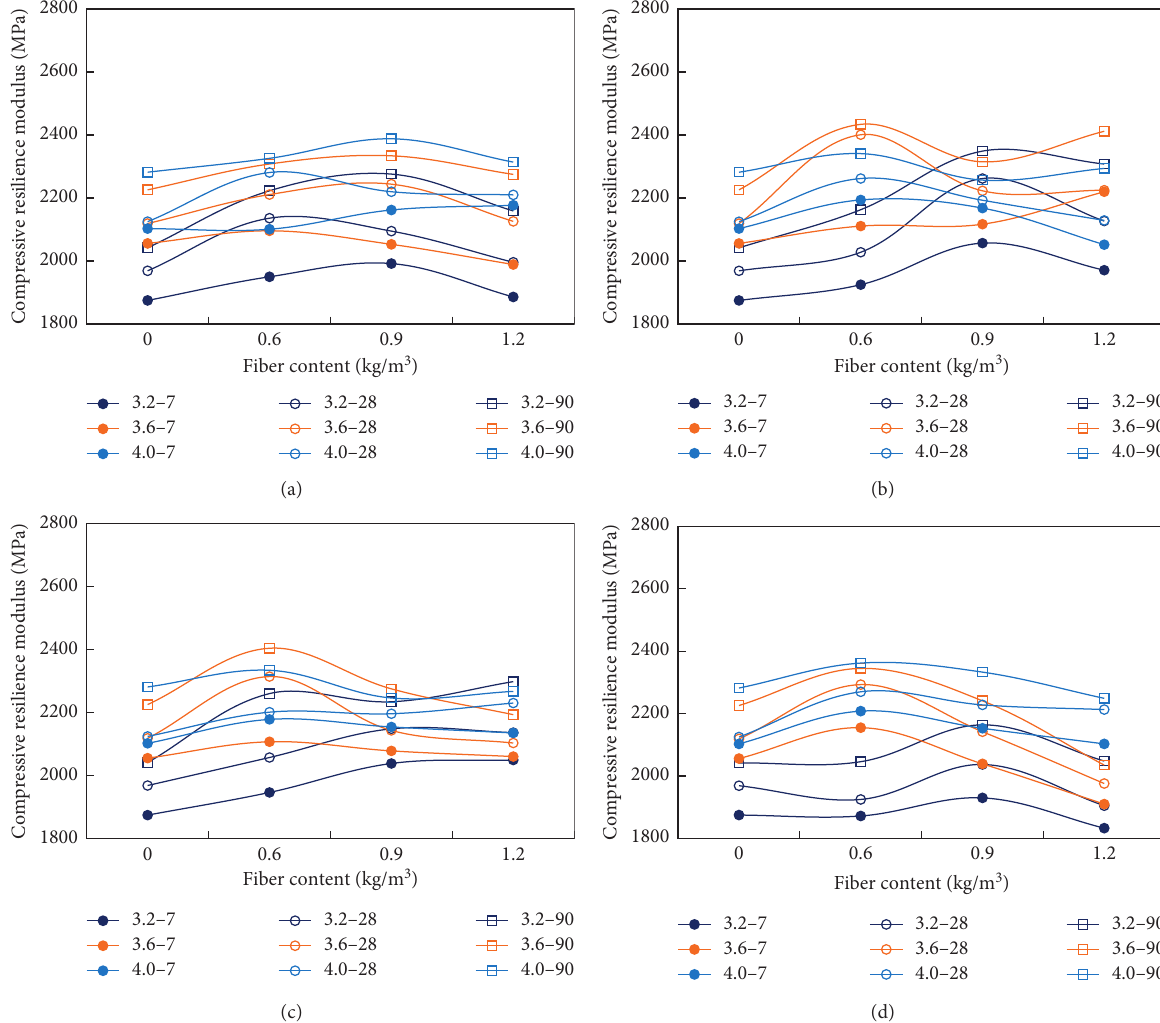
Figure 14: Trend chart of CRM of CSM. (a) Fiber length of 12mm, (b) fiber length of 18mm, (c) fiber length of 24mm, and (d) fiber length of 30mm.